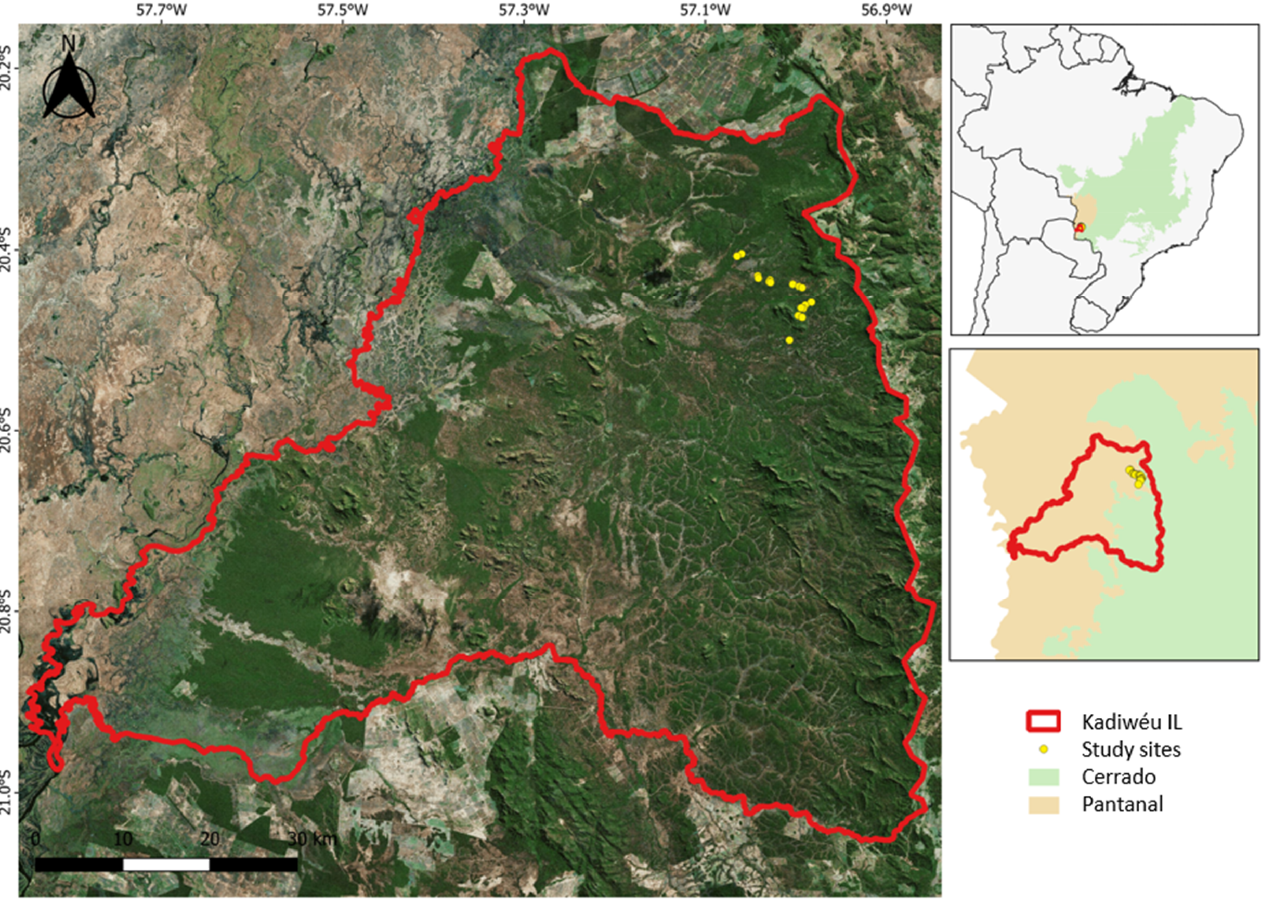
Figure 1. Location of the study sites where sun spiders were sampled in the Kadiwéu Indigenous Reserve, Porto Murtinho, Mato Grosso do Sul, Brazil.